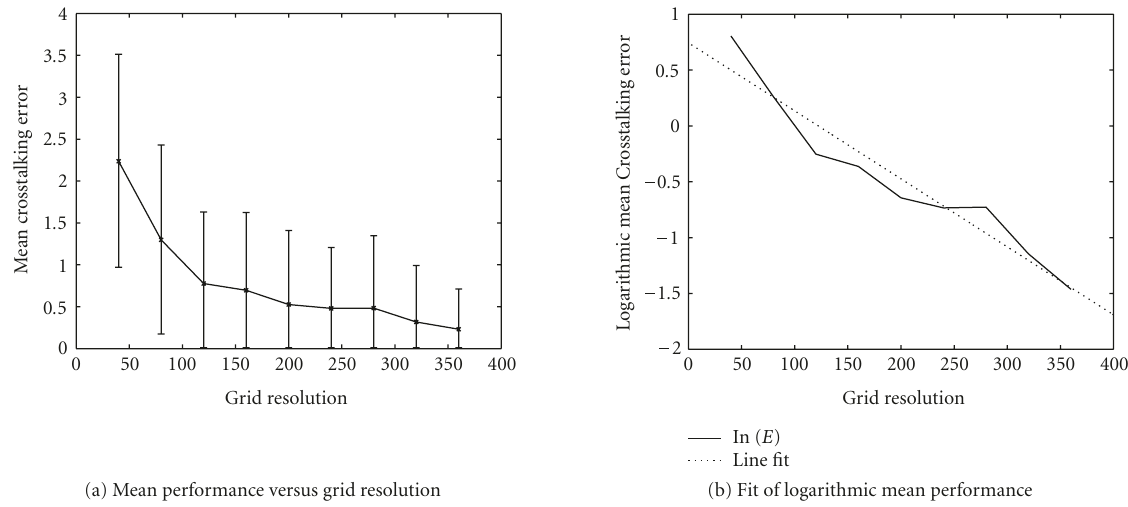
Figure 6: Dependence of Hough SCA performance (a) on the grid resolution β ; mean has been taken over 50 runs. With a logarithmic y -axis (b), a least squares line fit confirms the linear dependence of performance and β − 1 .